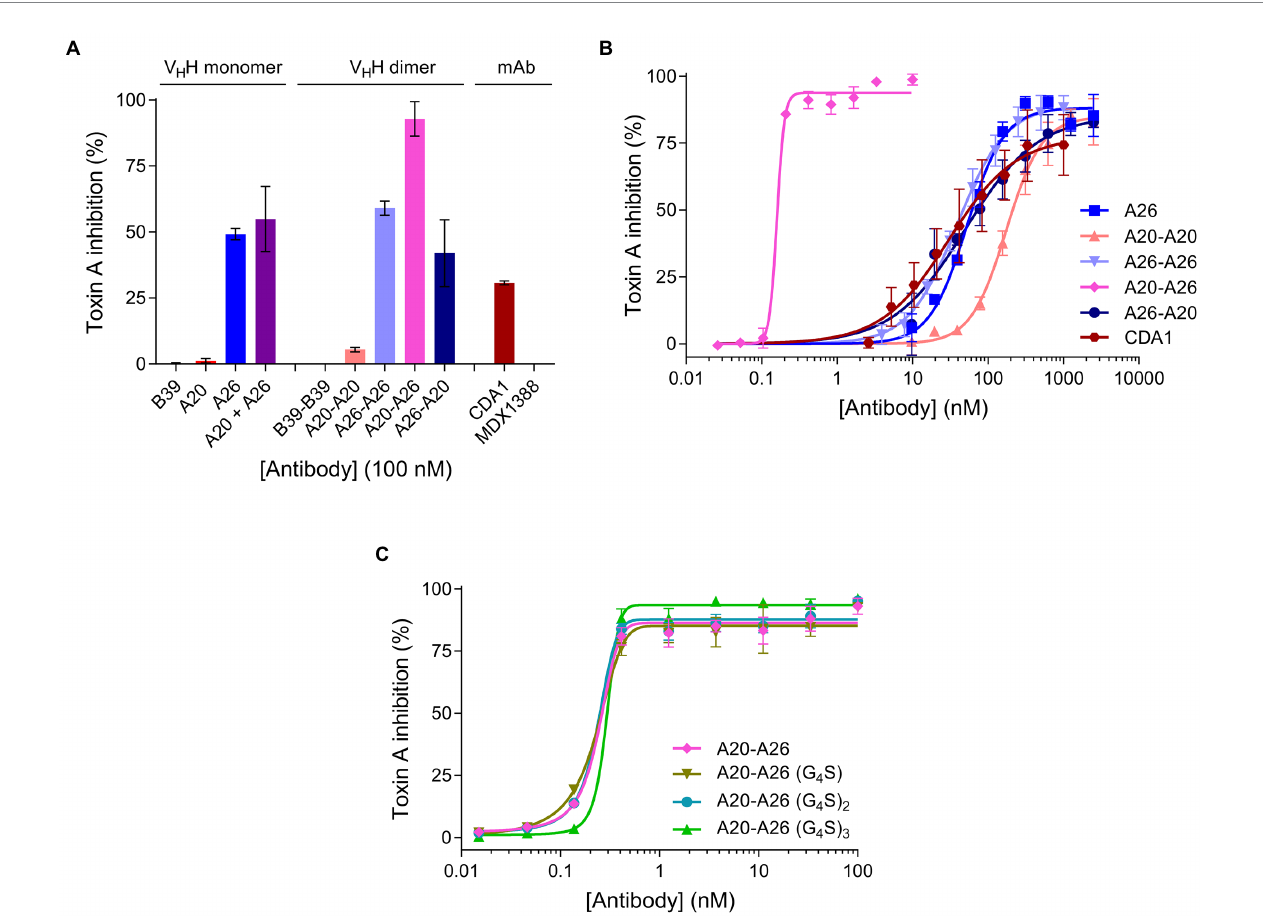
FIGURE 3 In vitro neutralization of TcdA cytotoxicity. (A) The panel of antibodies at 100 nM were incubated with TcdA for 72 h and the percentage of live Vero cells were quantified by the colorimetric proliferation reagent WST-1. MDX1388 (anti-TcdB mAb) and B39-B39 (a dimer of the B39 V H H with a (GS) 6 linker) were negative control antibodies. (B) The most potent antibodies were further titrated to evaluate their performance based on potency ( IC 50 and IC 99 ) and efficacy (maximum inhibition) values. (C) Comparison of neutralizing potency of the structure-guided A20-A26 construct containing a 12-amino acid linker, to A20-A26 constructs containing 5, 10, and 15 amino acid linkers. In all assays the TcdA concentration was 260 pM and antibody concentrations as described. Error bars indicate standard deviation (SD) of three technical